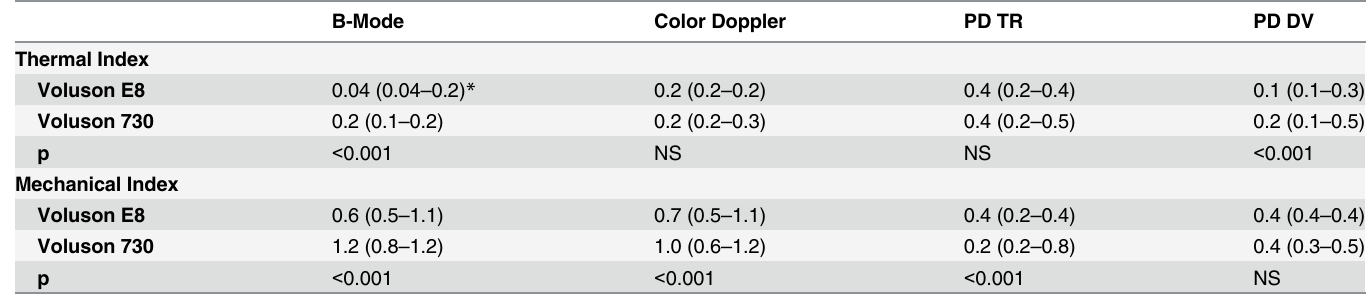
Table 2. The maximum acoustic output during evaluation of the fetal heart at the time of the first trimester